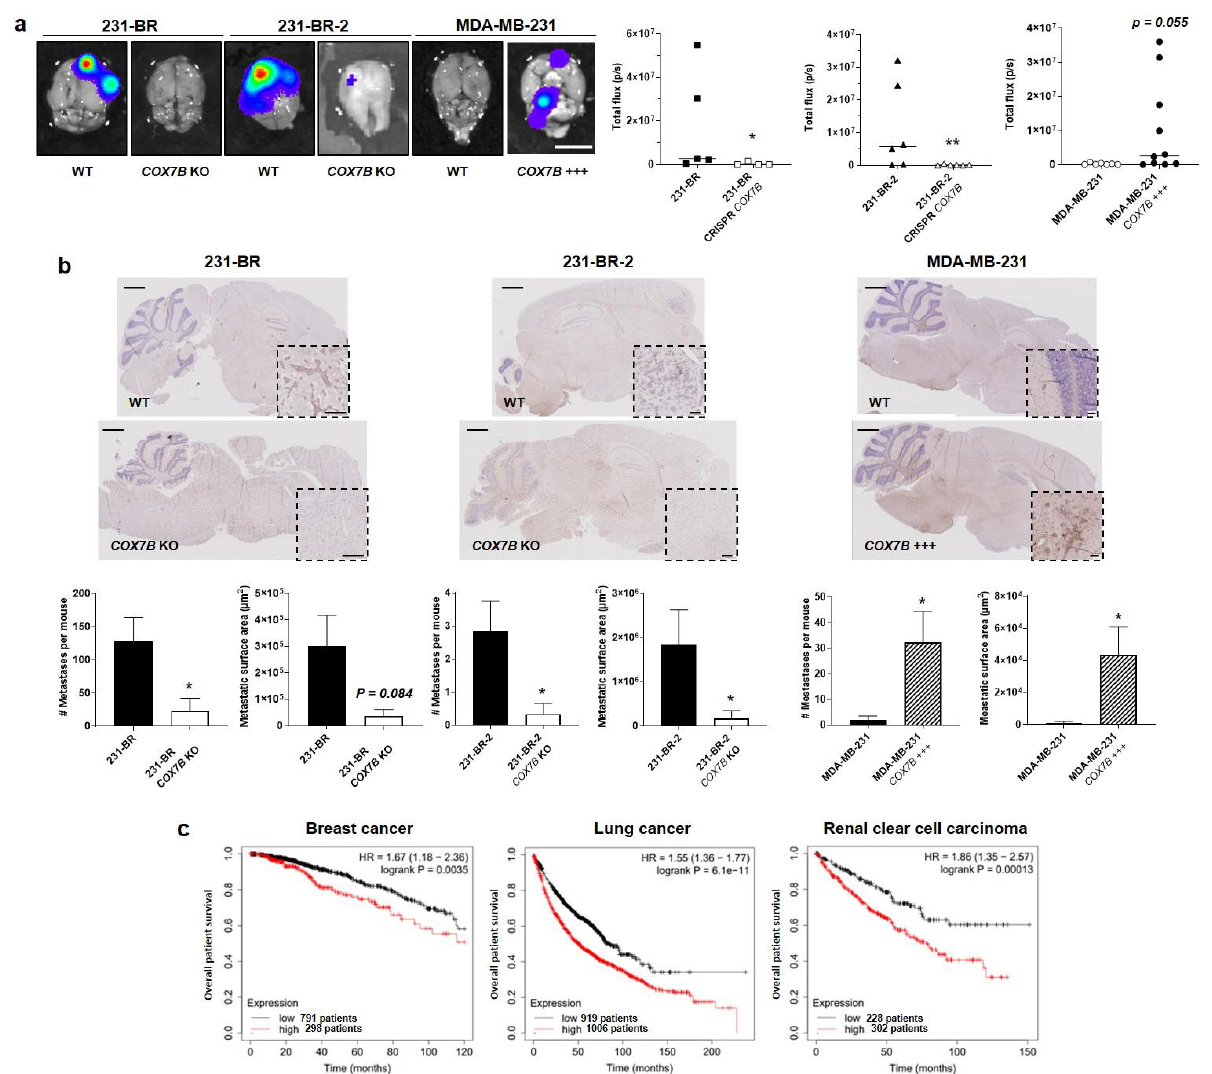
Figure 6. Cox7b drives the tropism of metastatic human breast cancer cells to the brain. ( a , b ) The brain tropism of 231-BR and 231-BR-2 brain-seeking variants, expressing or not Cox7b (KO using a CRISP-Cas9 strategy), and of parental MDA-MB-231 human breast cancer cells, overexpressing or not overexpressing Cox7b, was assessed using the protocol depicted in Figure 1a. The cells constitutively expressed luciferase and GFP. ( a ) Ex vivo bioluminescence imaging of mouse brains 4 weeks after the intracardiac injection of cancer cells. Pictures on the left are representative of mouse brains in luciferin-containing medium captured using a Xenogen IVIS 50 bioluminescence imaging system. Graphs on the right show brain bioluminescence intensity ( n = 4–10). ( b ) Central sections of the brains were immunostained for GFP and counterstained for hematoxylin and eosin. Representative pictures are shown on top (bars = 1 mm). Insets represent typical GFP-positive metastatic lesions (bars = 100 µ m). On the bottom, the left graphs represent the number of detected metastases ( left ) and the metastasis-positive surface area per mouse ( n = 4–10). Representative images of the brains are shown. ( c ) Overall survival of patients with breast cancer ( left , all types combined, 1090 patients), lung cancer ( middle , all types combined, 1925 patients) and renal clear cell carcinoma (RCC, right , 530 patients). Data are shown as individual values and medians ( a ), means ± SEM ( b ), or individual values ( c ). * p < 0.05, ** p < 0.01, using Mann–Whitney test ( a ), Student’s t-test ( b ), or log rank test ( c